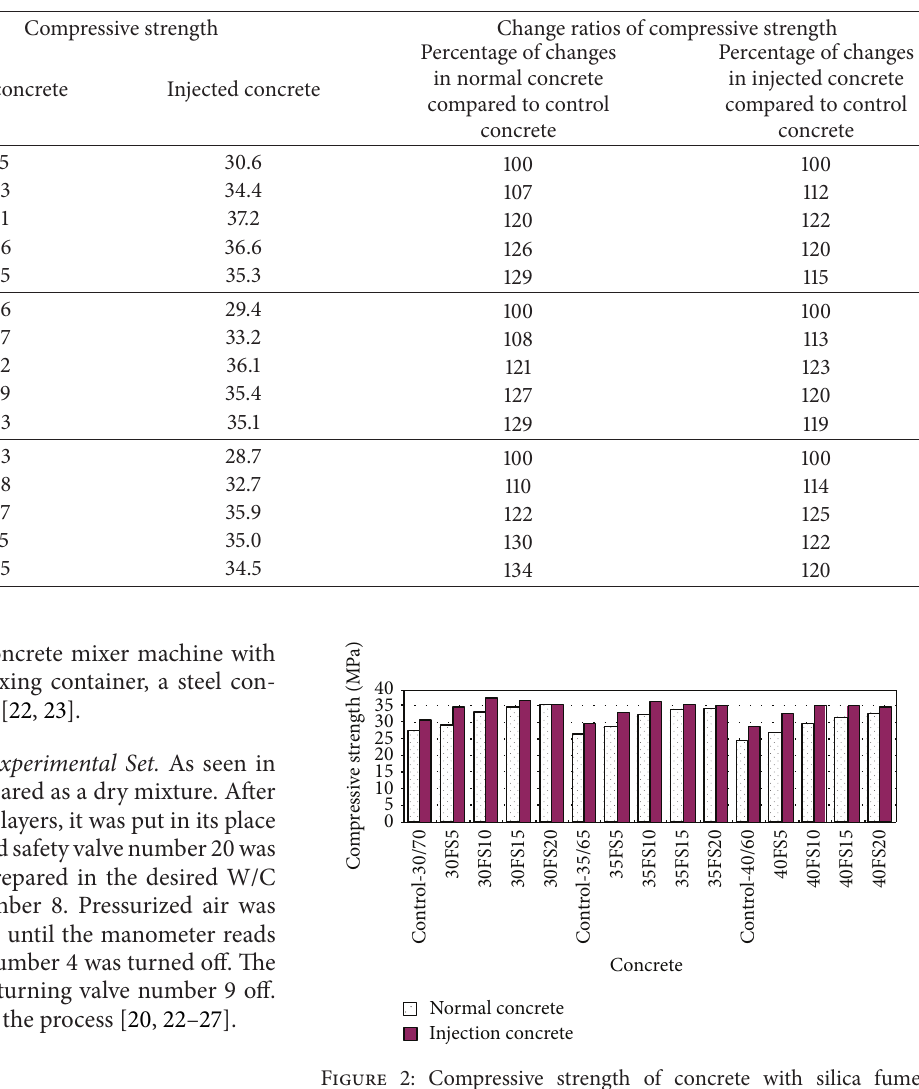
Table 5: Results of compressive strength of concrete groups (MPa).